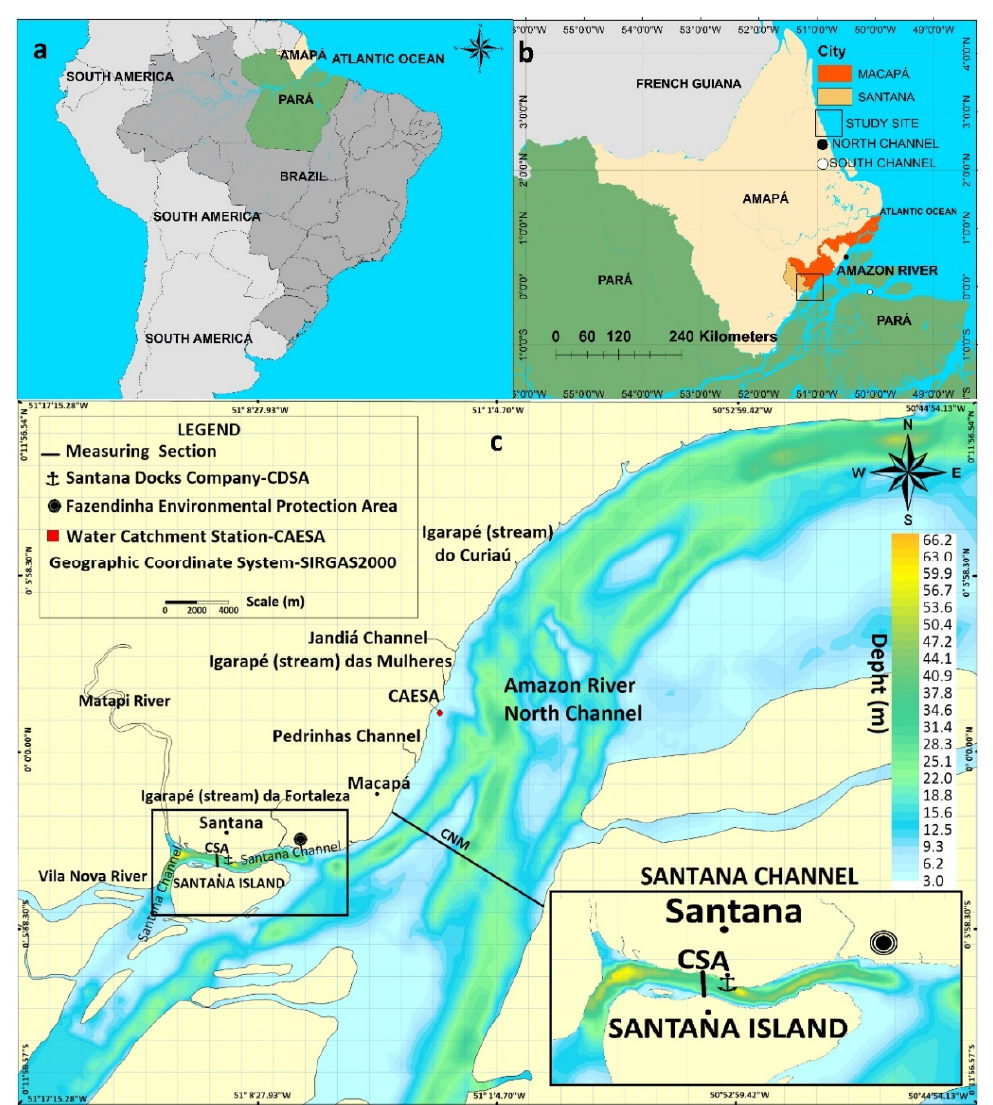
Figure 1. Study site: Santana Channel (CSA) and North Channel (CNM) bathymetry (depth)in meters below sea level. ( a ) Amapá State location in Brazil;( b ) State of Amapá and study site; ( c ) detailed study site. Geographic coordinate system: Sirgas2000.